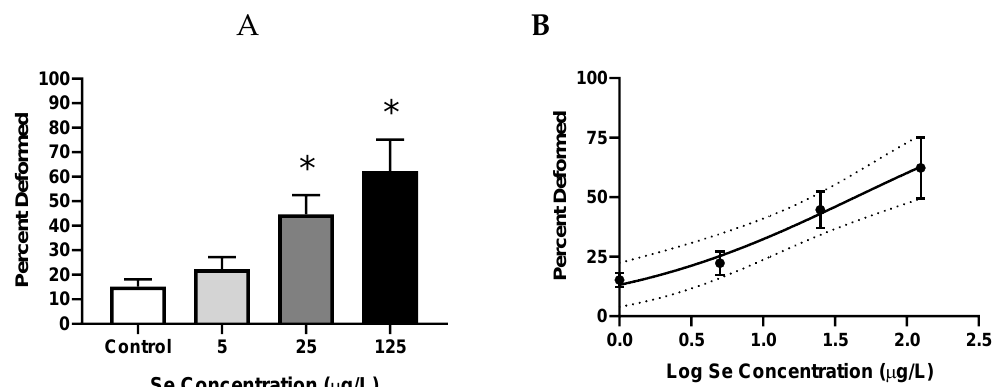
Figure 2. Morphological malformations at varying degrees of severity observed in larval zebrafish exposed to increasing concentrations of L-selenomethionine (SeMet) via embryo aqueous exposure during deformities analysis. Letters indicate level of severity; Control (C), Moderate (M), and Severe (S).